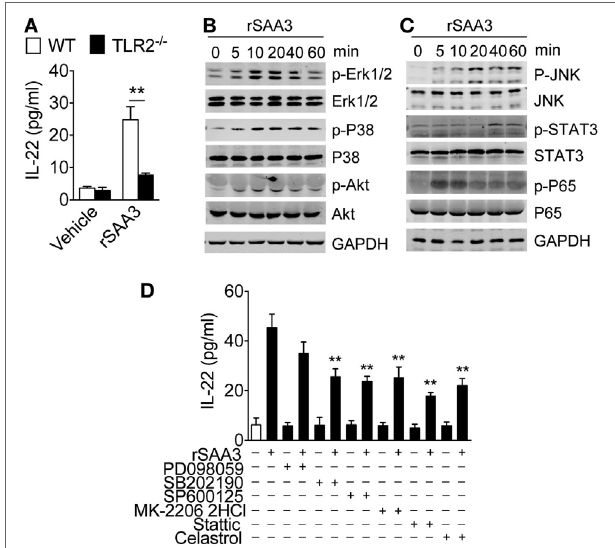
FigUre 7 | Regulation of serum amyloid A (SAA)3-induced IL-22 expression in neutrophils. (a) Bone marrow neutrophils from WT or Tlr2 − / − mice (both male and female, 8–10 weeks of age) were stimulated with recombinant SAA3 (rSAA3) (1 µM) or vehicle for 24 h. IL-22 release was measured by ELISA. (B,c) SAA3-induced phosphorylation of selected signaling molecules. Bone marrow neutrophils were treated with rSAA3 (1 µM) as indicated. Cells were collected at indicated time points and cell lysates were separated on SDS-PAGE for Western blotting using antibodies to the phosphorylated and total proteins of selected signaling molecules ( n = 3–5 mice for each group). (D) Pharmacological inhibition of SAA3-induced IL-22 secretion. Bone marrow neutrophils were pre-treated with the ERK1/2 inhibitor PD98059 (100 µM), p38 inhibitor SB202190 (100 µM), JNK inhibitor SP600125 (10 µM), Akt inhibitor MK-2206 2HCl (10 µM), STAT3 inhibitor static (10 µM), and NF- κ B inhibitor celastrol (100 µM) for 1 h before rSAA3 (or medium only) stimulation for 24 h. The released IL-22 was quantified by ELISA ( n = 3–5 mice for each